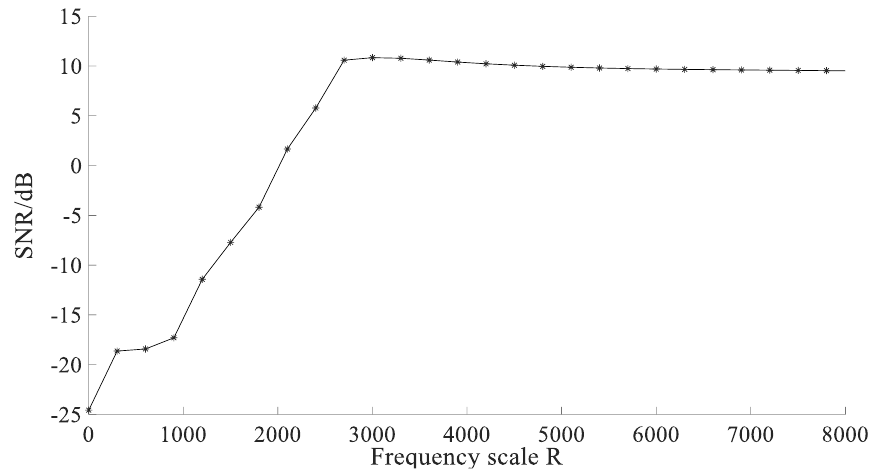
Figure 2. The output SNR of the proposed method with R. determination of the range of